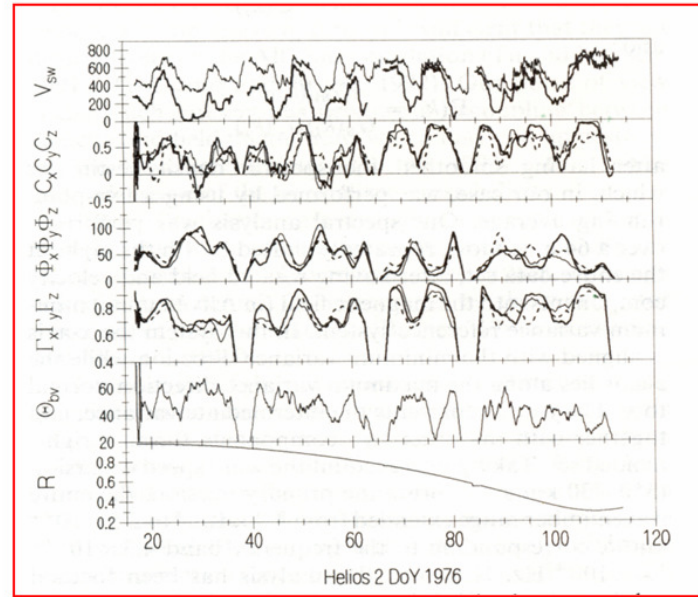
Figure 79: Wind speed profile 𝑉 and | 𝜎 c | 𝑉 are shown in the top panel. The lower three panels refer to correlation coefficient, phase angle and coherence for the three components of 𝛿𝑉 and 𝛿𝐵 fluctuations, respectively. The successive panel indicates the value of the angle between magnetic field and velocity fluctuations minimum variance directions. The bottom panel refers to the heliocentric distance (from Bruno and Bavassano,